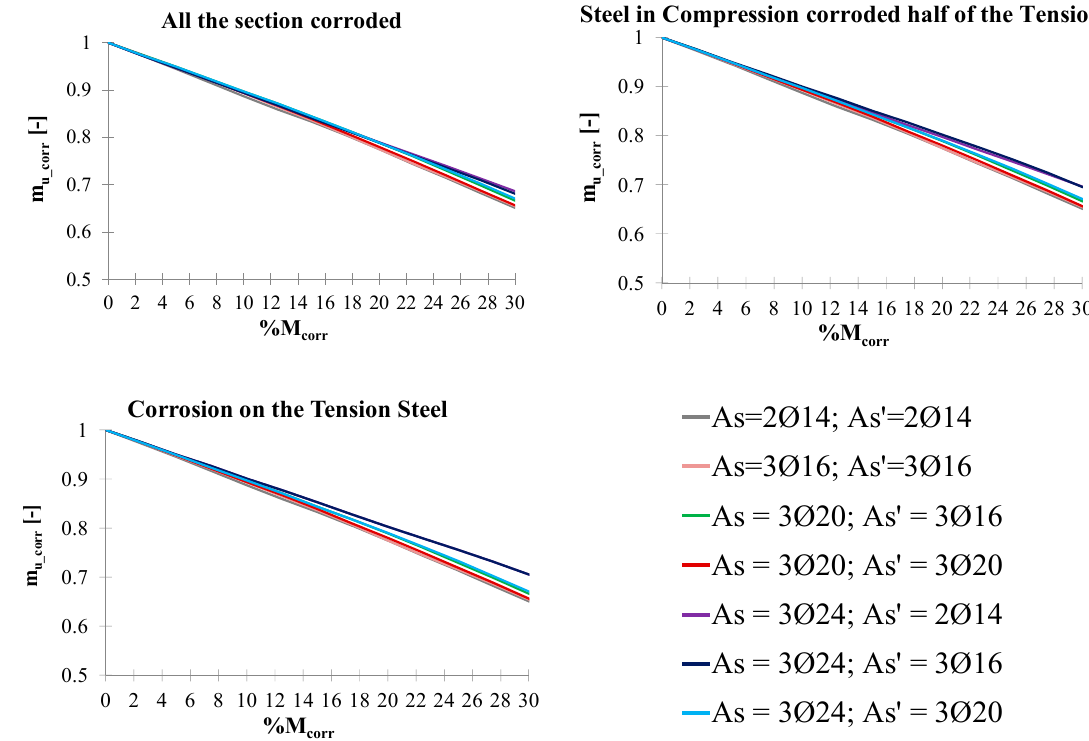
Figure 6. Nondimensional ultimate bending moment for different corrosion scenarios—formed Beam, uniform corrosion.